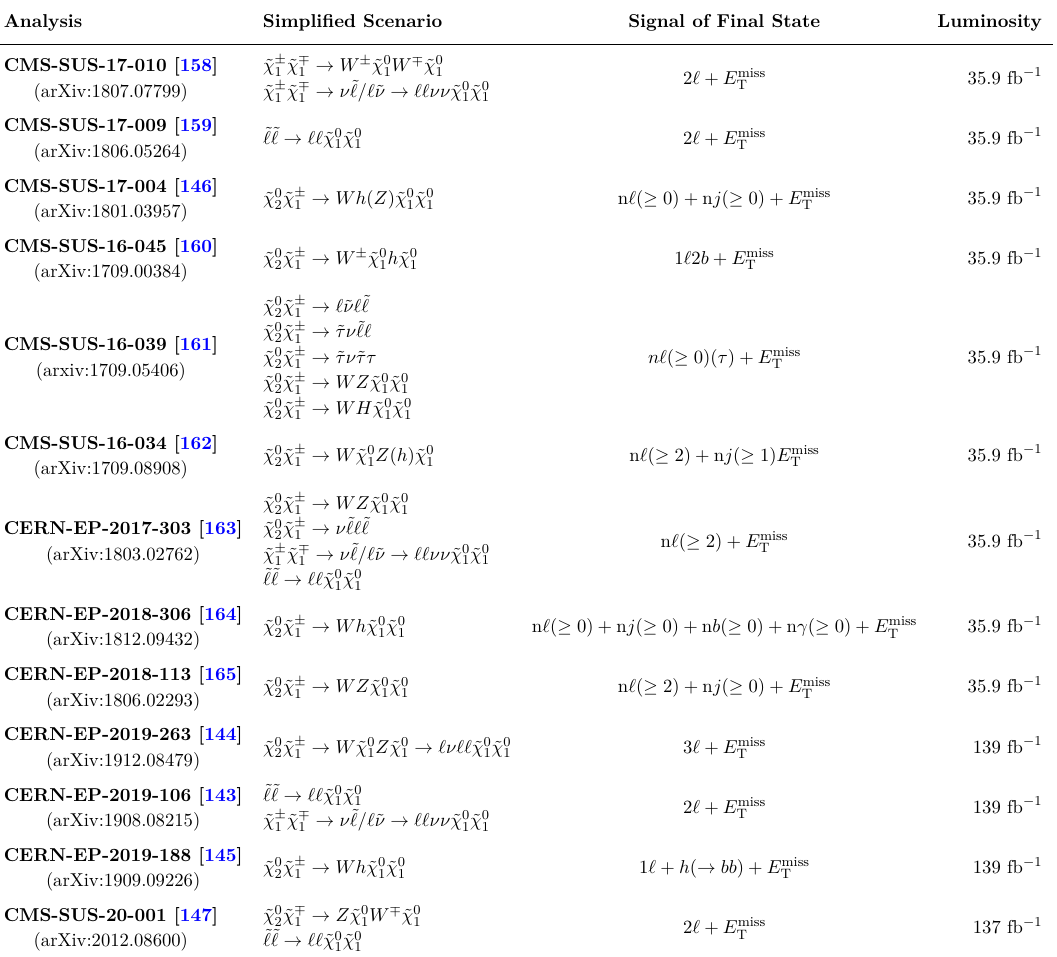
Table 3 . Signal of final state for electroweakino pair-production processes considered in this work. Relevant experimental analyses were performed in simplified models by ATLAS and CMS collabo- rations, and their results have been encoded in SmodelS-1.2.3